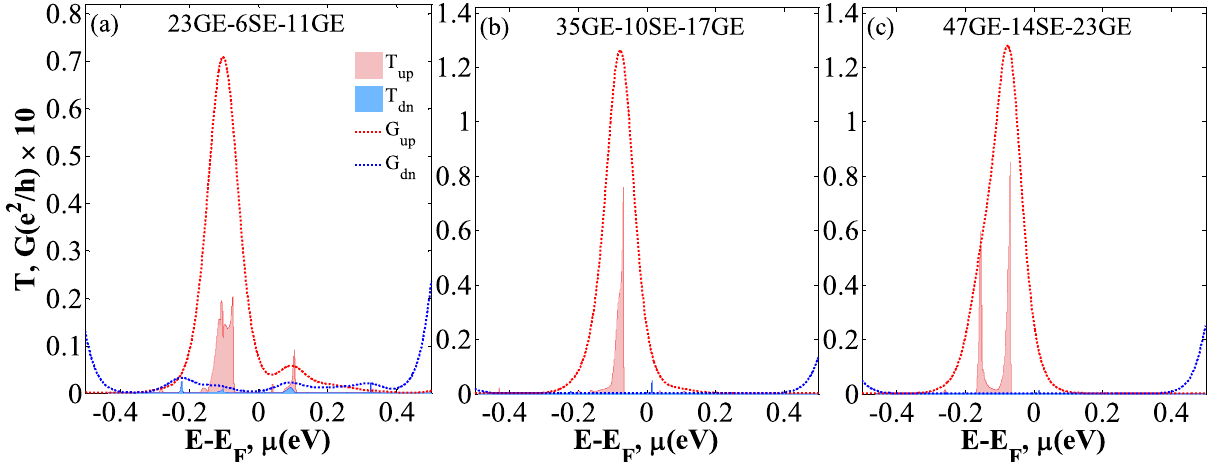
Figure 4. Panels ( a ), ( b ), and ( c ) show the variation of the spin-dependent transmission spectra ( T up and T dn ) against E – E F (filled area) and dotted lines show the variation of the spin-dependent electrical conductance ( G up and G dn ) versus µ for the 23GE-6SE-11GE, 35GE-10SE-17GE, and 47GE-14SE-23GE configurations, respectively, at T = 300